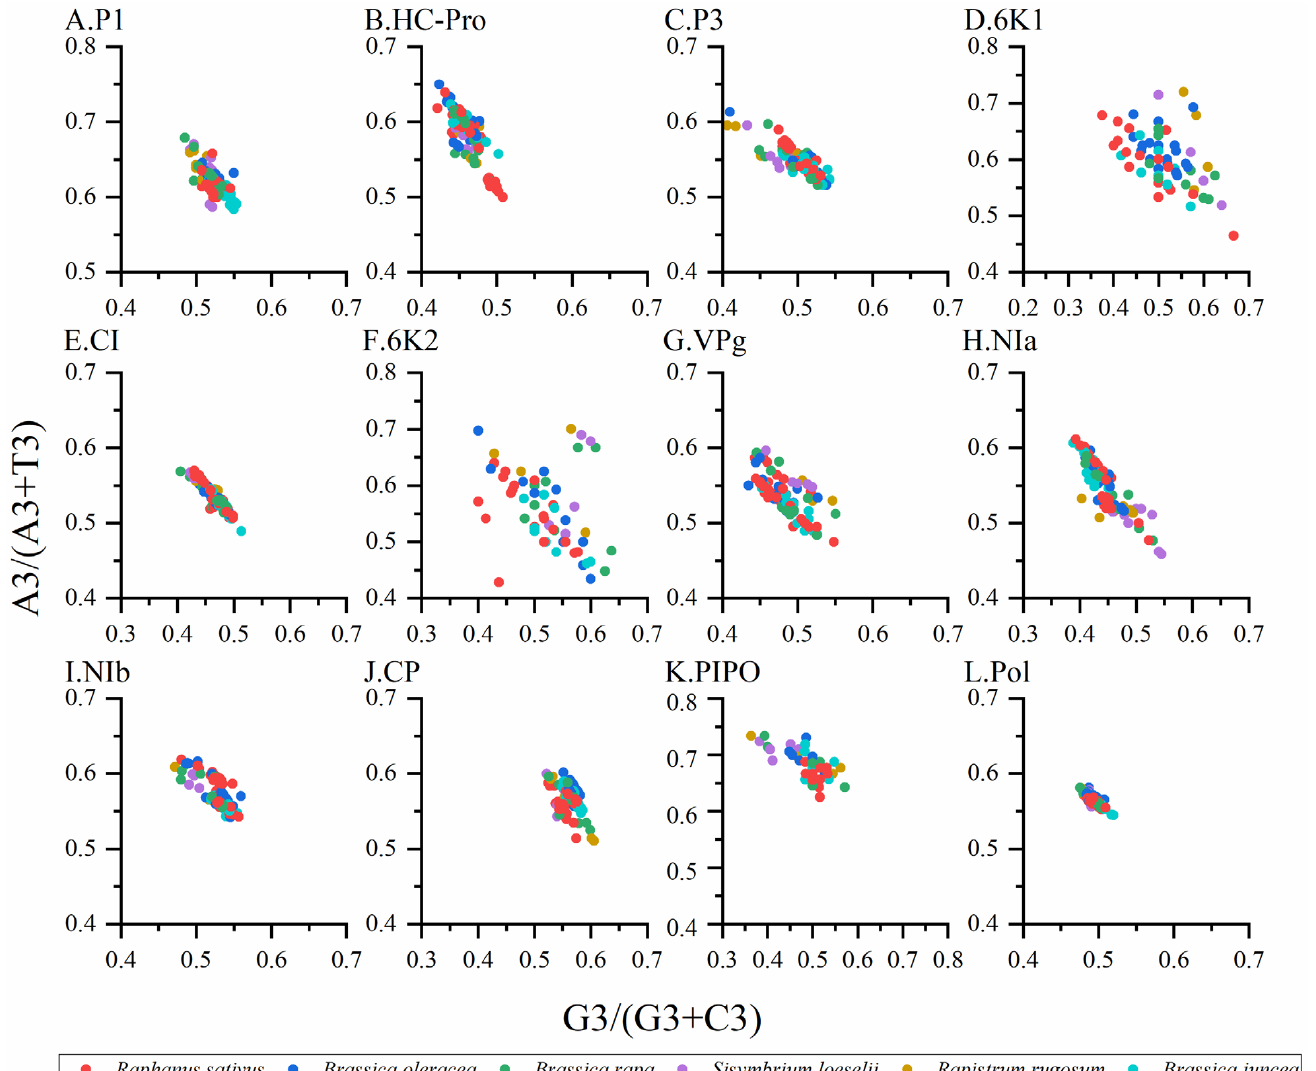
Figure 5. Parity plot showing the presence of AT bias [A3%/(A3% + T3%)] and GC bias [G3%/(G3% + C3%)] for the individual protein ( A – K ) and complete polyprotein ( L ) coding sequences of turnip mosaic virus. The center of the plot, where the value of both the coordinates is 0.5, indicates the place where there is no bias in the mutation or selection rates. The Raphanus sativus, Brassica oleracea, Brassica rapa, Sisymbrium loeseli, Rapistrum rugosum and Brassica juncea hosts are represented in red, blue, green, purple, orange, wathet blue and brown, respectively.